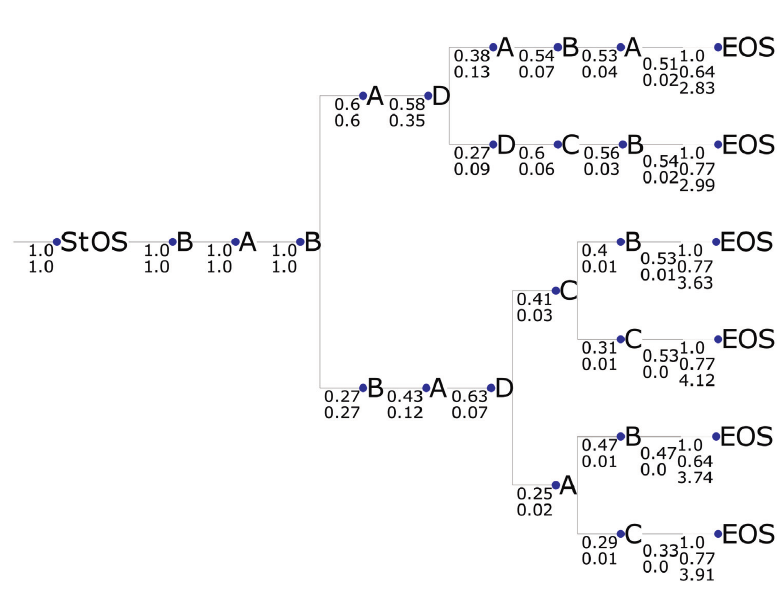
Figure 18: Output of the seq2probTree method for the tree-based system with input sequence [B A B].